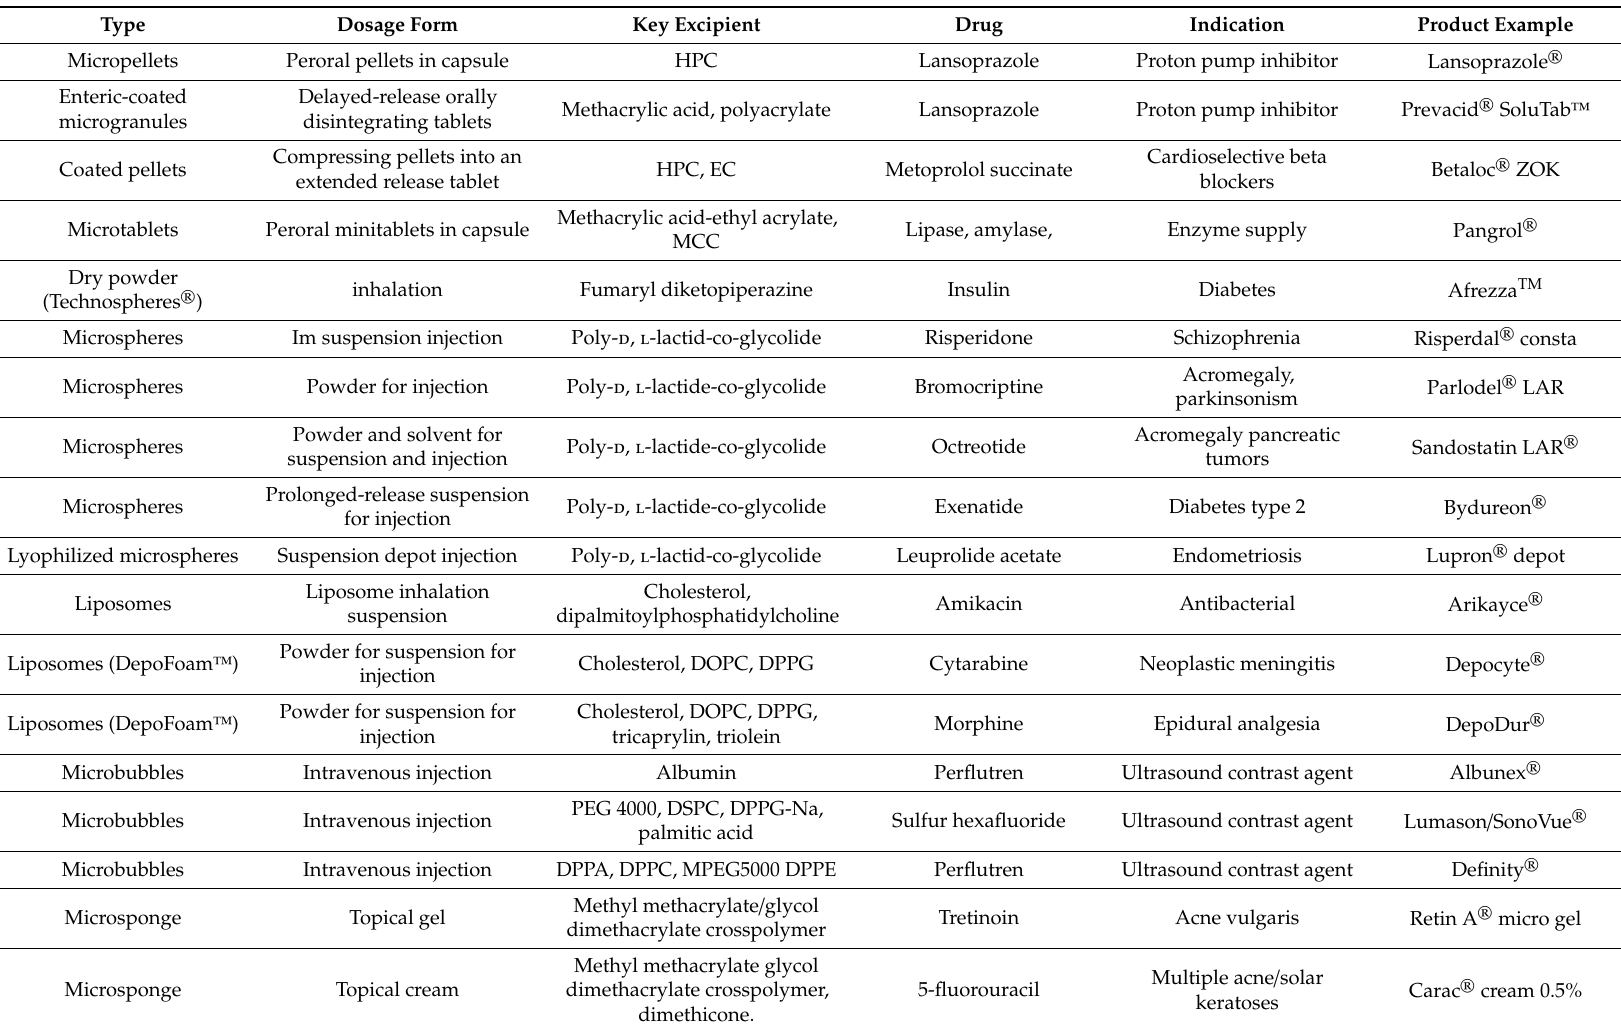
Table 8. Types of multiparticulate systems in